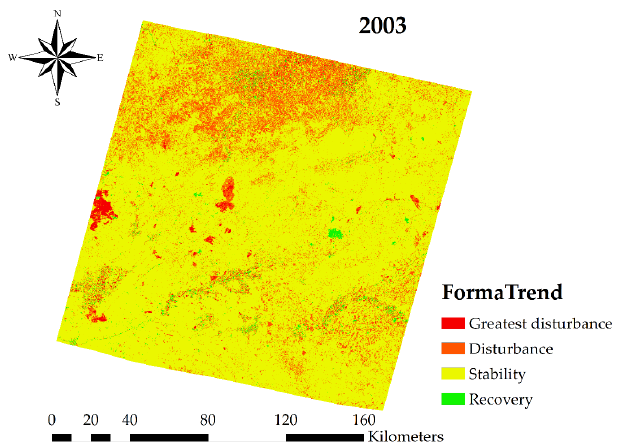
Figure 5. Spatial patterns of disturbance and recovery by Forma Trend (FT) for the year 2003. The areas without change (stability) appear in yellow, areas of recovery in green, and areas of disturbance in red.